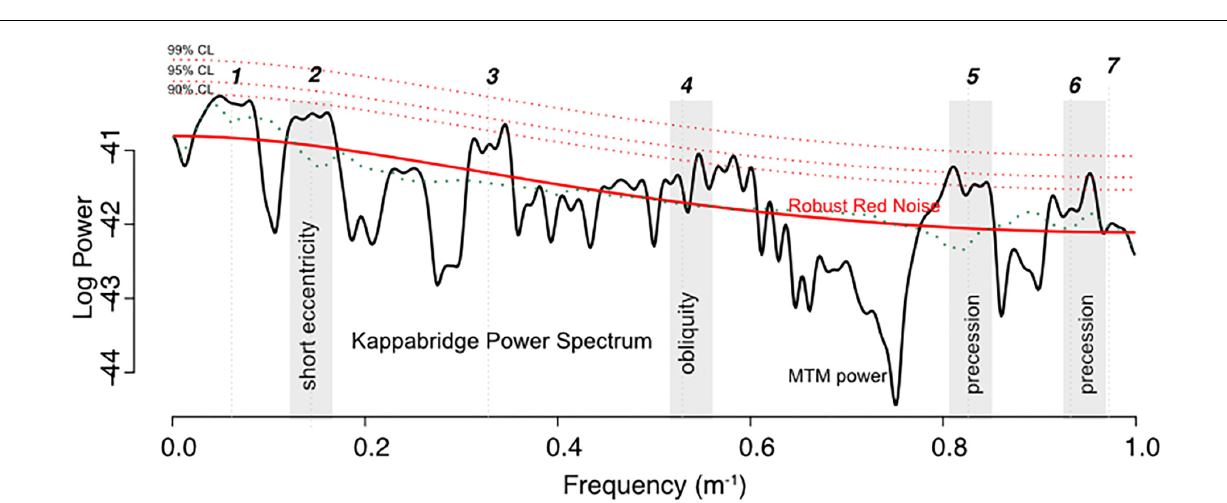
FIGURE 5 | Log power spectrum for the Kappabridge measured magnetic susceptibility time series shown in Figure 3 showing significant peaks chosen by Astrochron (Meyers, 2014) and numbered (confidence limit set to 0.85). The shaded bands show our choice for the Milankovitch cycles. See Table 2 for the periods/frequencies of the numbered